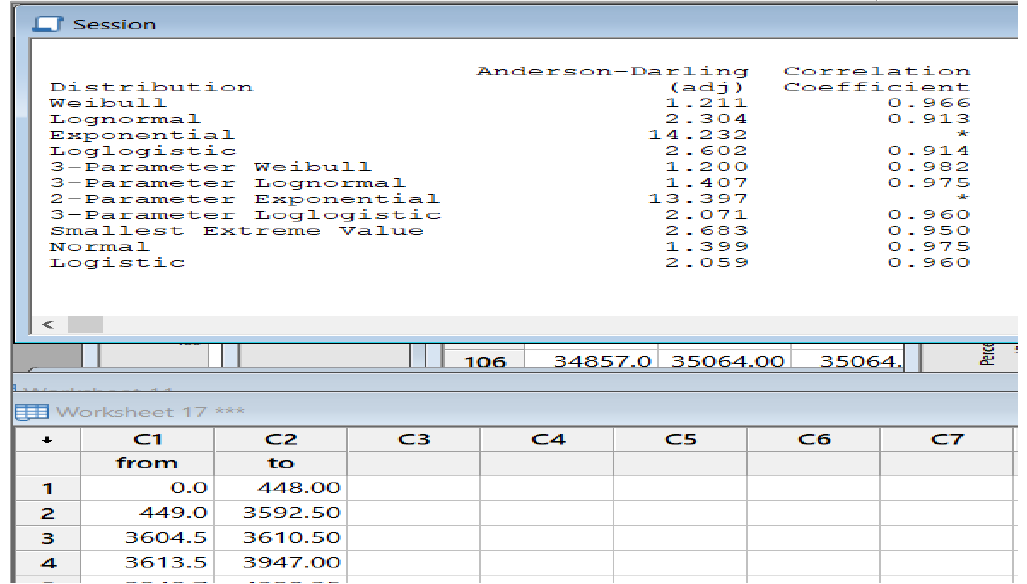
Fig. 4. Graph of Best Distribution.